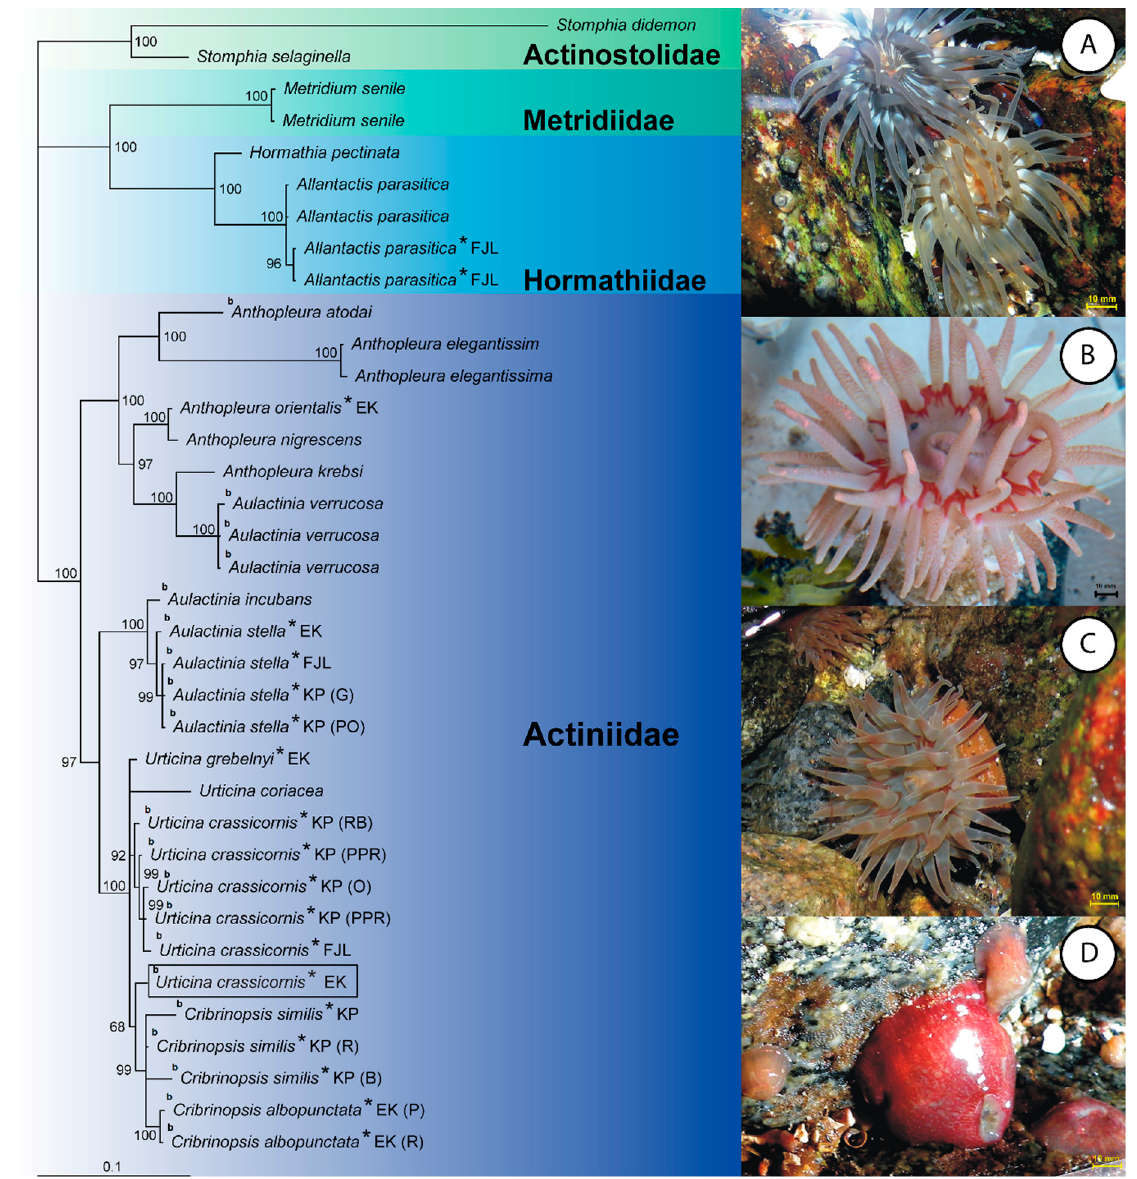
Figure 2. Neighbor-joining tree from 28S rDNA sequences. The asterisk indicates the sample analyzed in this study, the others are taken from GenBank. Letters next to the species name indicate the collection site of species reported in this study (KP—Kola Peninsula, FJL—Franz Josef Land, EK—East Kamchatka). The color pattern for specimens of Urticina crassicornis, Cribrinopsis similis, Cribrinopsis albopunctata , and Aulactinia stella are given in parenthesis (PPR—pale pink with red stripes, PP—pale pink, RB—red–blue blotched, PO—pale orange, OG—orange with gray tentacles, O—orange, R—red, G—gray, B—beige). The color pictures: A—two morphs (gray—G and pale orange—PO) of Aulactinia stella, B— Cribrinopsis similis (beige—B), C— Urticina crassicornis (orange—O), D— Urticina crassicornis (red—R). Numbers at nodes are posterior probability values. The letter b indicates the species with the brooding strategy. The framed name Urticina crassicornis from the Pacific is probably a different species.